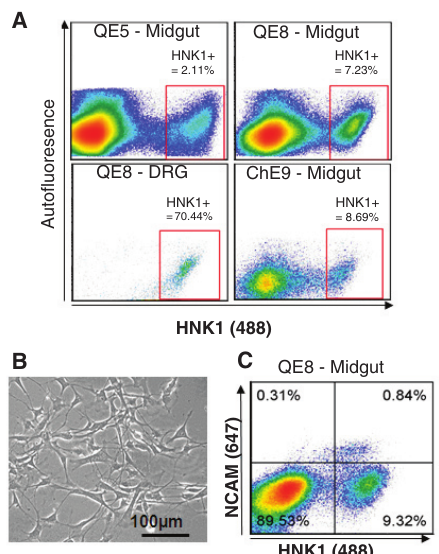
Supplemental Figure S3. Qualitative (q) PCR of HNK1 sorted cells. To assess the enrichment for ENC markers following FACS for HNK1, QE8 midgut-derived cells were assessed for expression of SOX10 (a NC marker) and Hu-D (a neuronal marker). Cell populations analysed by qPCR were cells which were not sorted (pre-sort), sorted cells which were not HNK1 +ve (-ve sort) and HNK1 +ve sorted cells (HNK1). HNK1 +ve cells showed a significant increase in expression of the markers tested when compared with pre-sorted cells indicating successful enrichment of ENC cells by FACS.